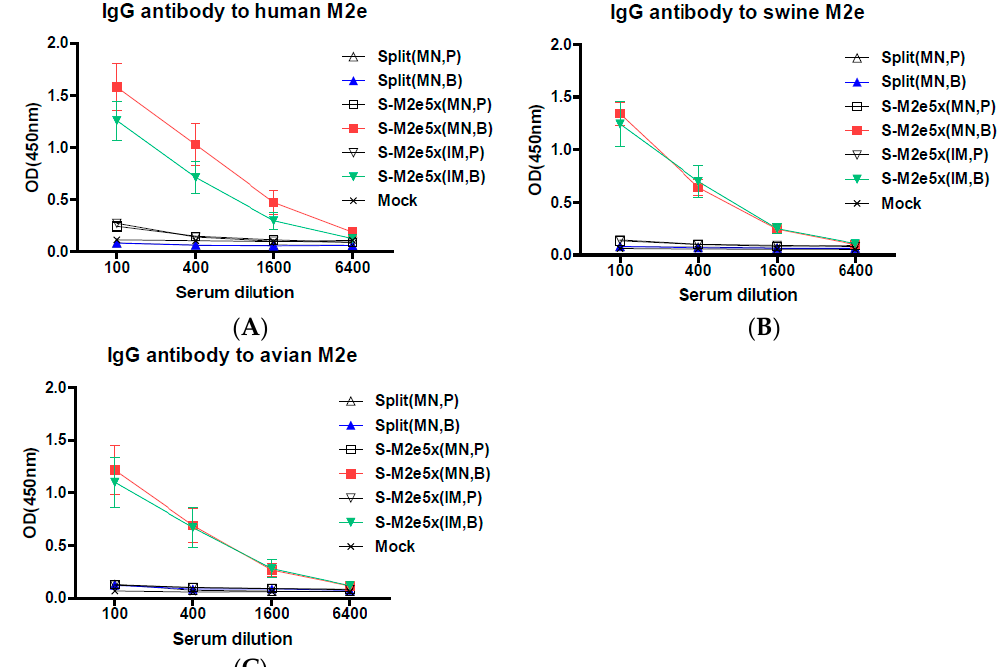
Figure 2. M2e5x VLP supplemented vaccination induces M2e-specific antibodies. BALB/c mice were microneedle (MN) immunized on the skin with split vaccine alone (Split MN, N = 12), co-immunized with split vaccine and M2e5x VLP via separate MN delivery to the skin (S-M2e5x MN, N = 12), or immunized with split vaccine M2e5x VLP on the different legs by intramuscular (IM) route (S-M2e5x IM, N = 12). Sera were collected 3 weeks after prime (P) and boost (B) vaccination. The IgG level was detected using M2e peptides as an ELISA coating antigen. ( A ) IgG antibody responses to human M2e peptide. ( B ) IgG antibody responses to swine M2e peptide. ( C ) Comparison of IgG antibody responses to avian M2e peptide. Error bars indicate mean ± SEM.